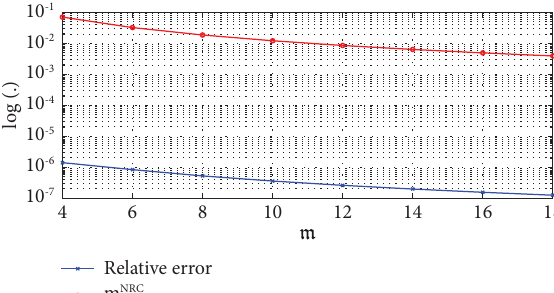
Figure 2: Relative error and m NRC (in log scale) for diferent m for Example 4.